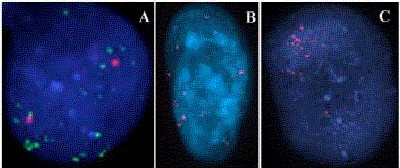
FISH validation of some of the high-level amplifications (6p12.1, 8q24.3 and 17p11.2) identified by array CGH. Interphase cells hybridized with centromere 6 (red)/RP11-81F7 (green) in case 274 (A), RP11-89K10 (red) in case 527 (B) and RP11-189D22 (red) in case 364 (C). The ploidy of these cases was determined based on the modal chromosome number of the respective cases, e.g. diploid (case 426) triploid (cases 274 and 364), and tetraploid (case 527).